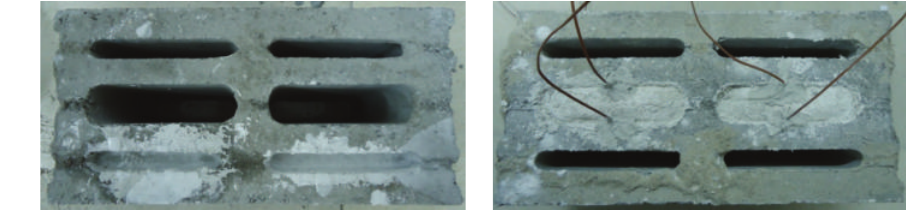
Figure 2: PCM blocks.